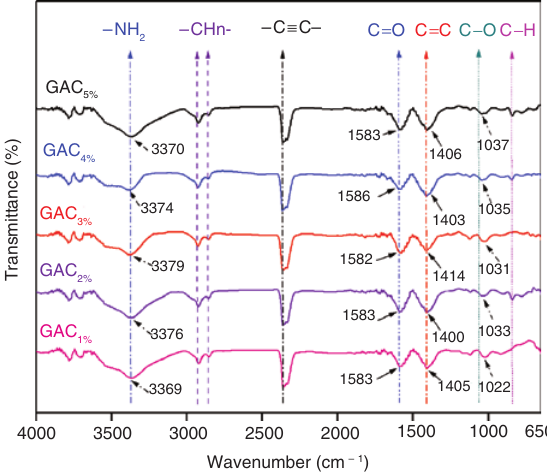
Figure 4: Fourier transform infrared (FTIR) spectra of the glucose activated carbon (AC) samples at various triethylenetetramine (TETA) impregnation